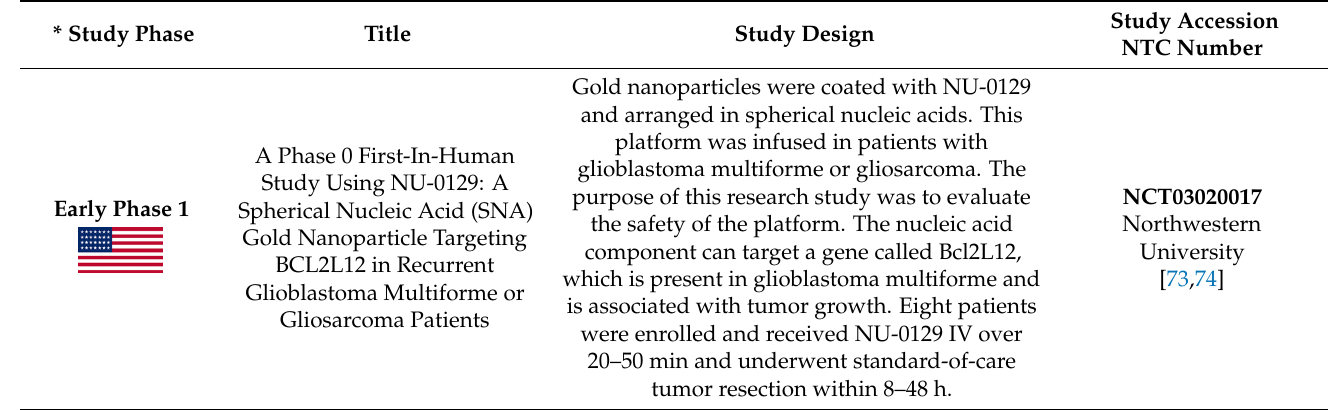
Table 2. Clinical trials applying AuNPs for diagnosis and treatment of brain, salivary gland, and gastric tumors.